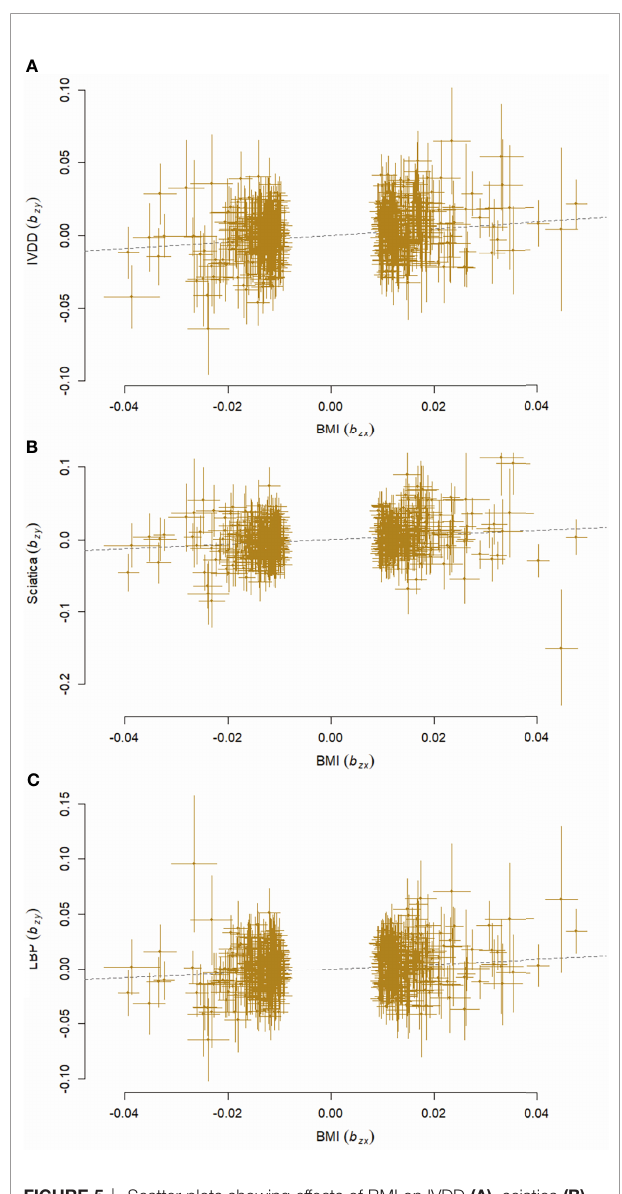
FIGURE 5 | Scatter plots showing effects of BMI on IVDD (A) , sciatica (B) , and LBP (C) with GSMR analyses. BMI, body mass index; IVDD, intervertebral disc degeneration; LBP, low back